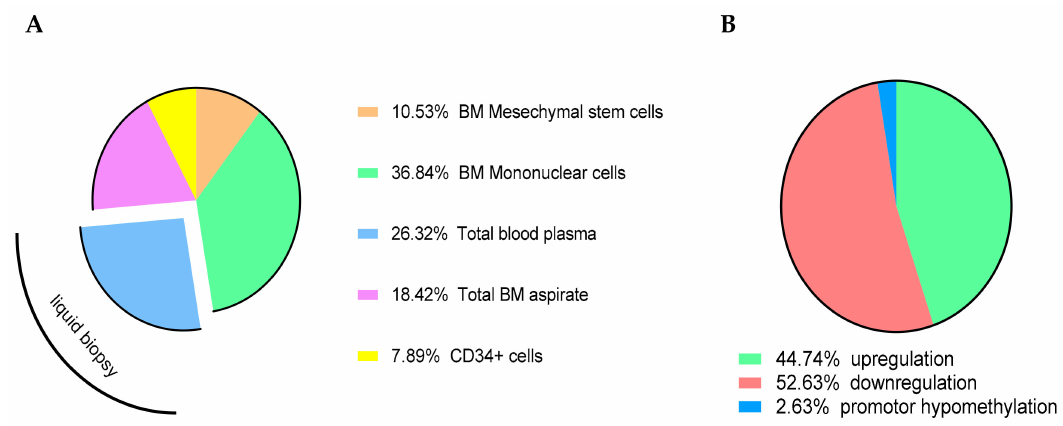
Figure 1. Cellular source and miRNA dysregulation. ( A ) MiRNA expression data based on various di ff erent materials / sources used including total BM or blood aspirates, BM mononuclear cells, or isolated CD34 + cells. ( B ) Reviewing these studies, a specific deregulation of miRNAs could not be